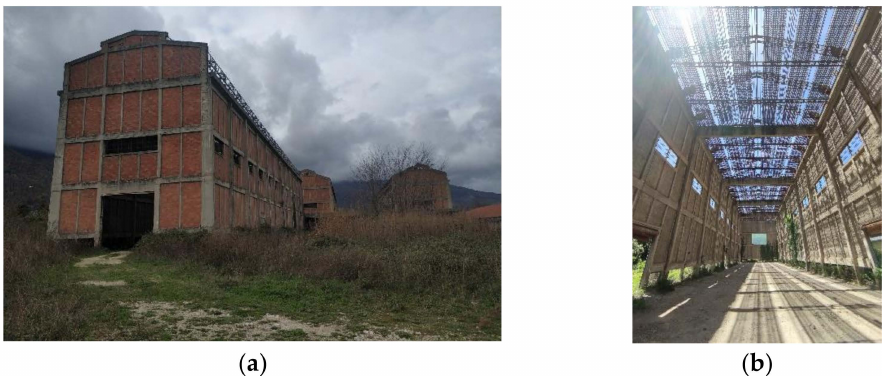
Figure 1. The former tobacco factory in Cervinara: ( a ) outdoor; ( b ) indoor.